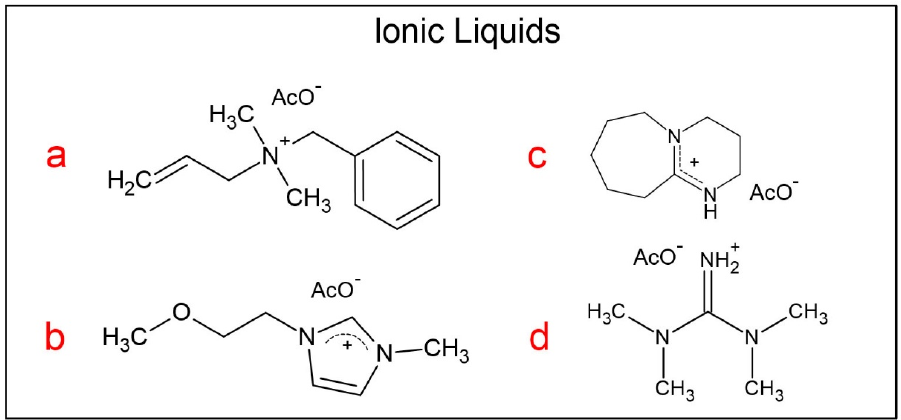
Figure 1. Molecular structures of the ionic liquids (ILs) employed, including: ( a ) allylbenzyldi methylammonium acetate (AlBzMe 2 NAcO); ( b ) 1-(2-methoxyethyl)-3-methylimidazolium acetate (C 3 OMeImAcO); ( c ) 1,8-diazabicyclo[5.4.0]undec-7-ene-8-ium acetate (DBUHAcO); ( d ) tetramethy lguanidinium acetate